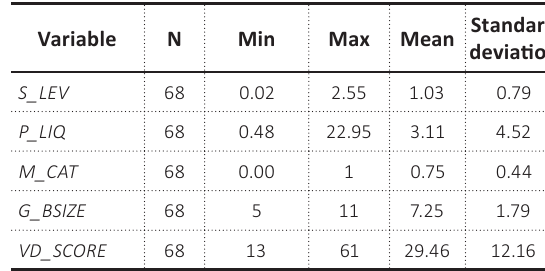
Table 2. Descriptive statistics of the study